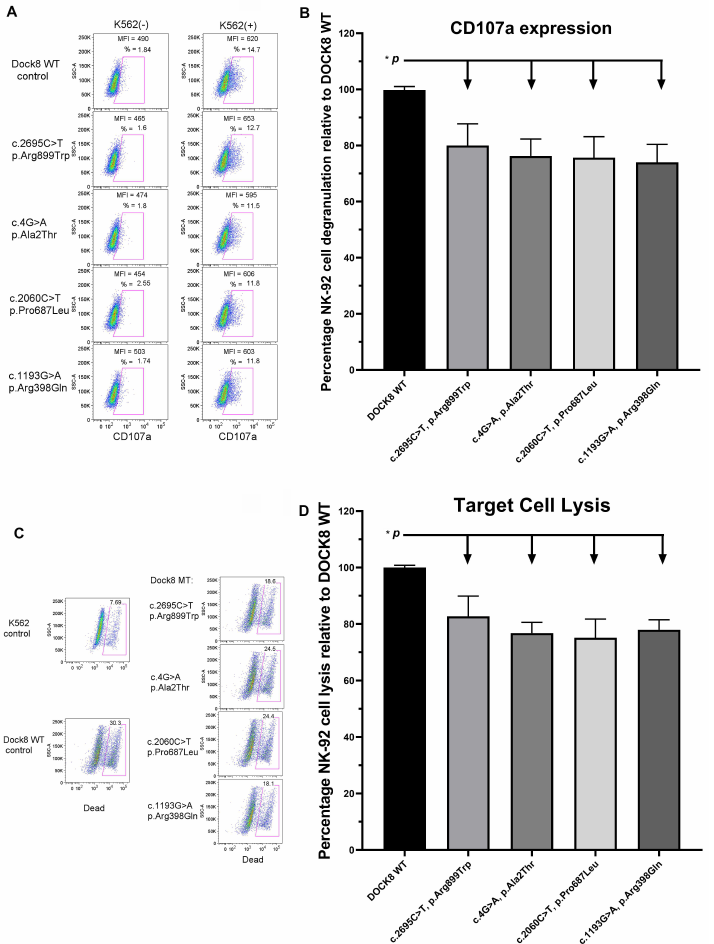
Figure 1. DOCK8 missense mutations from MIS-C patients are found to decrease NK cell degranula- tion and cytotoxicity. ( A ). Flow cytometry pseudo-color plots reveal decreased CD107a expression (degranulation) in FV-transfected NK-92 cells that express the 4 different patient-derived DOCK8 mutations in comparison with WT DOCK8-transfected NK-92 (control). ( B ). Summary bar graph shows CD107a expression levels in FV-transfected NK-92 cells that express 4 different patient-derived DOCK8 mutations relative to WT DOCK8-transfected cells. Statistical analysis shows ( n = 4, means ± SD %) significant differences ( t test comparisons between WT and each mutant, p < 0.05 for each). ( C ). Flow cytometry pseudo-color plots reveal decreased cytotoxicity in FV-transfected NK-92 cells that express the 4 different patient-derived DOCK8 mutations in comparison with WT DOCK8- transfected NK-92 (control). ( D ). Summary bar graph shows percentage cytotoxicity values in FV-transfected NK-92 cells that express 4 different patient-derived DOCK8 mutations relative to WT DOCK8-transfected cells. Statistical analysis shows ( n = 4, means ± SD %) significant differences (denoted by *, t test comparisons between WT and each mutant, p < 0.05 for